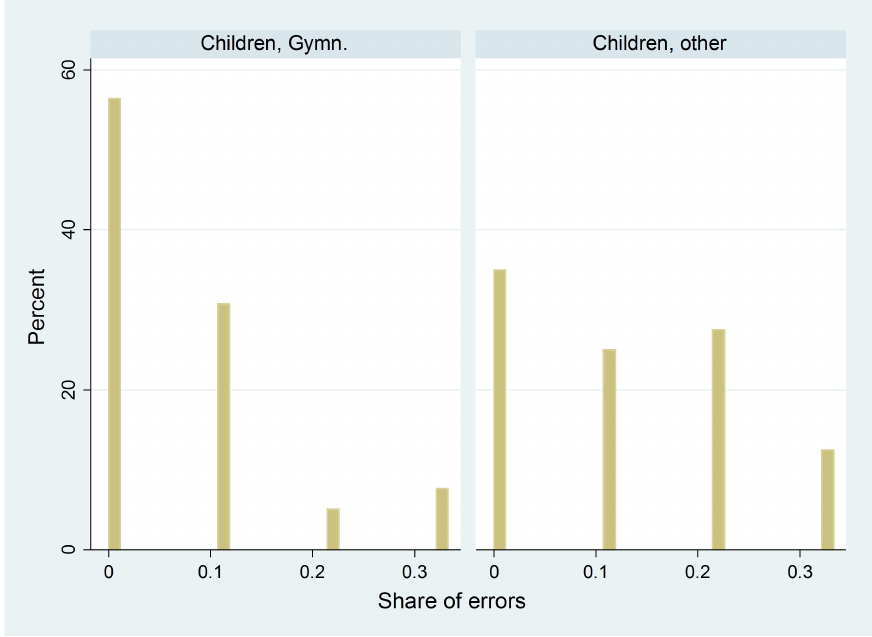
Figure 6. Distribution of errors across